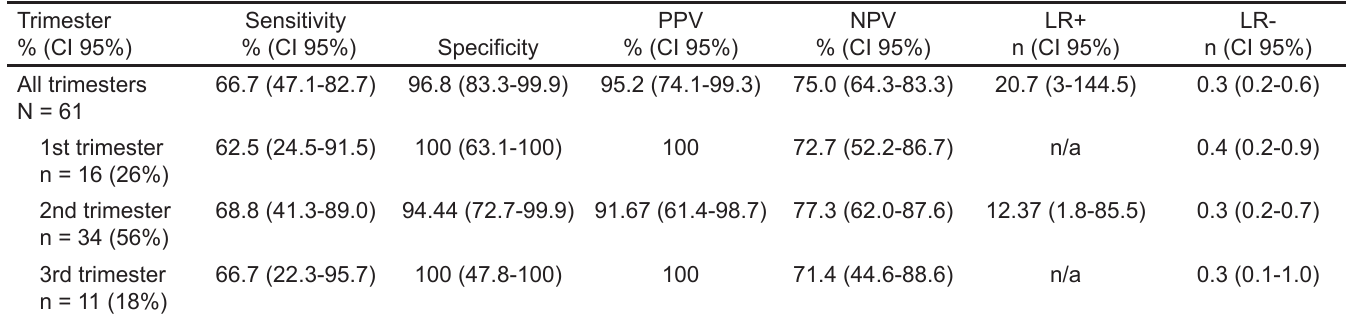
Table 2. Performance criteria of ultrasound.